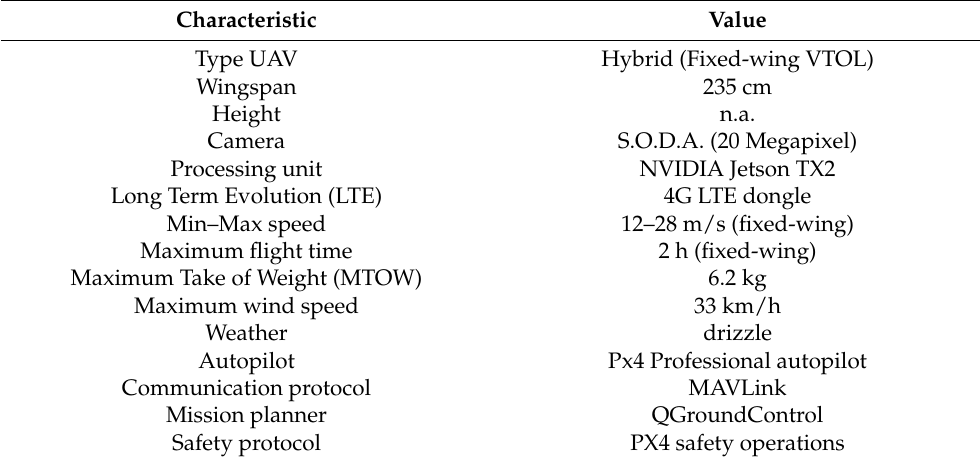
Table 1. Technical specifications for the DeltaQuad Pro (n.a. = not applicable).